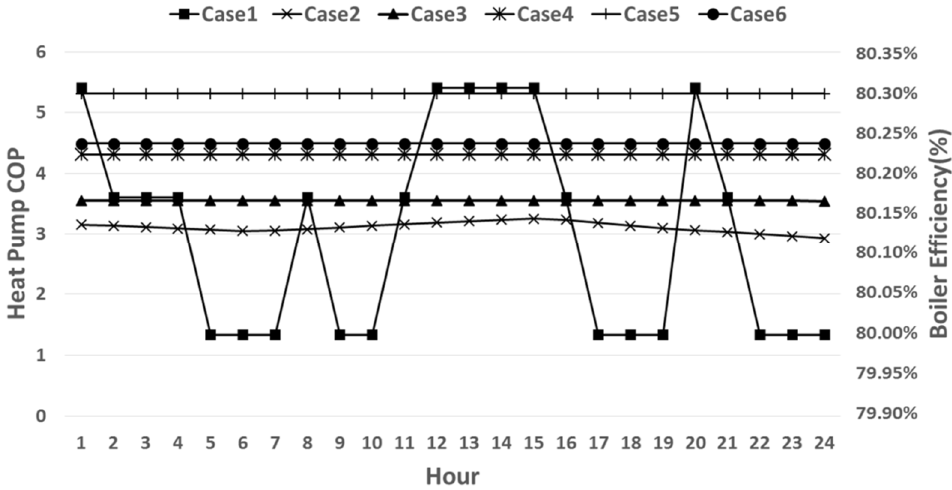
Figure 3. Boiler efficiency and heat pump COP variations